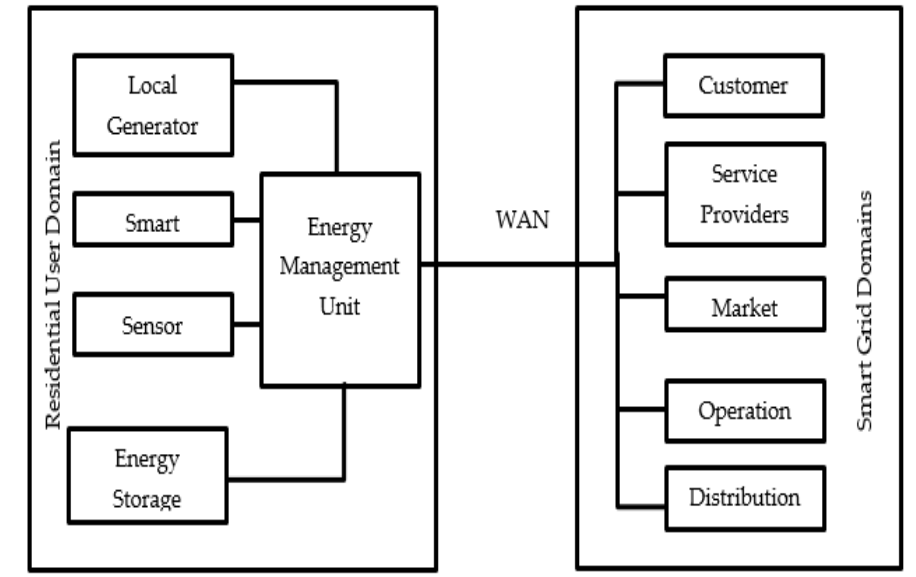
Figure 5. Diagrammatic presentation of the DSM system [52].